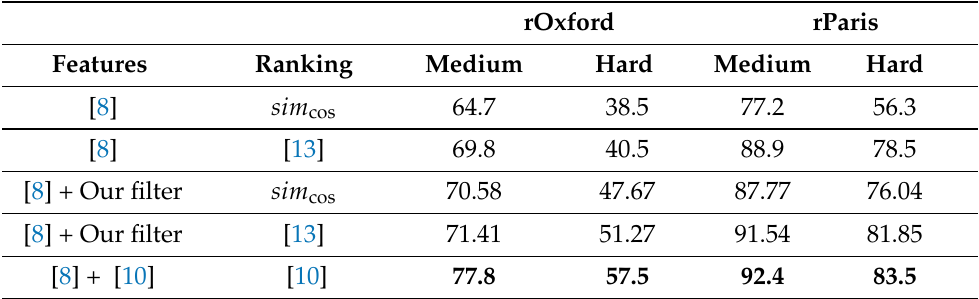
Table 5. mAP retrieval results comparison, results that do not include our filter are extracted as is from [10]. Best results per column are